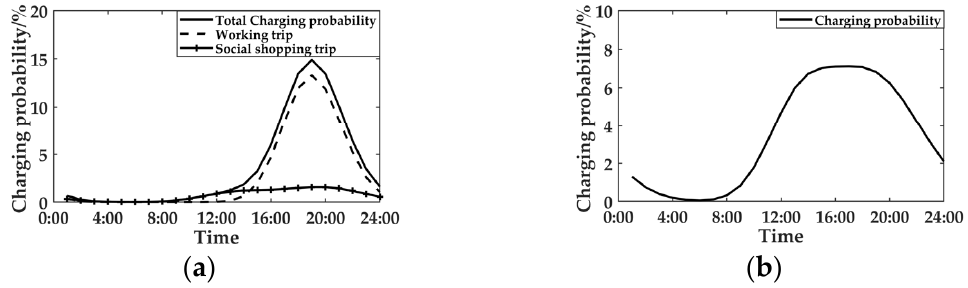
Table 4. Average charging time of EVs in residential areas.